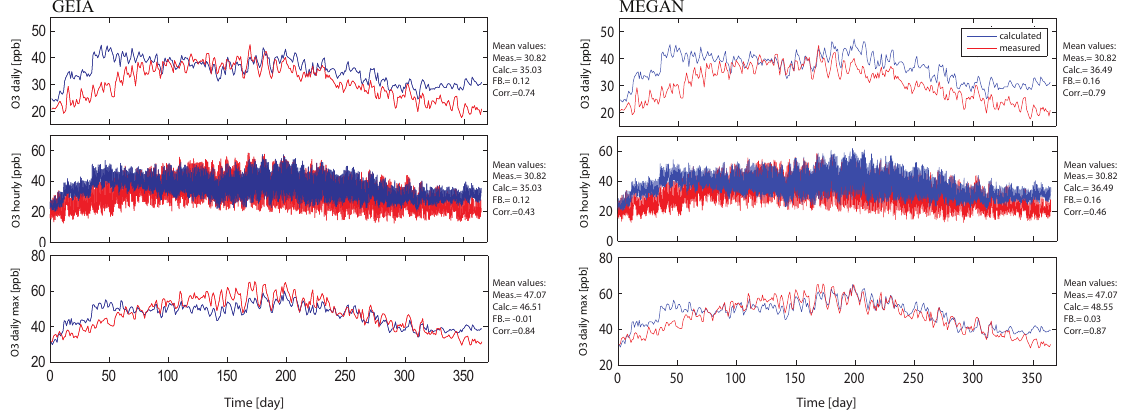
Mean values: Meas.= 30.82 Calc.= 36.49 FB.= 0.16 Corr.=0.79